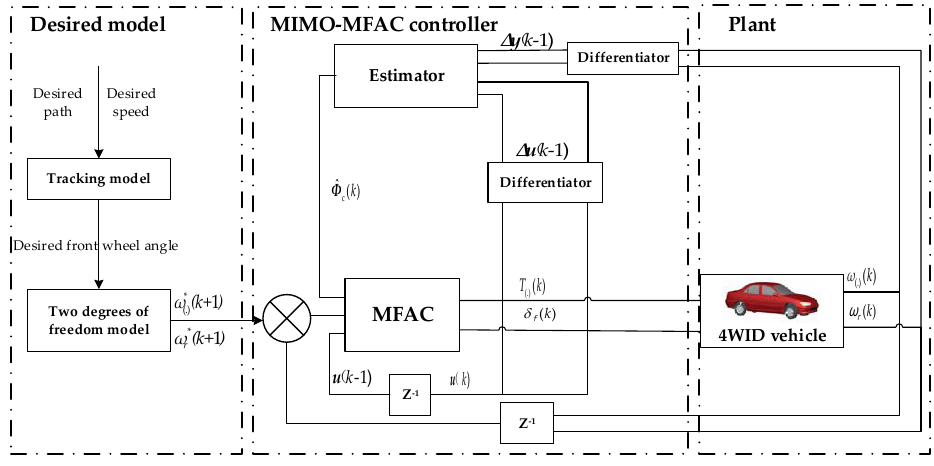
Figure 1. Architecture of MIMO-MFA active fault-tolerant control method.